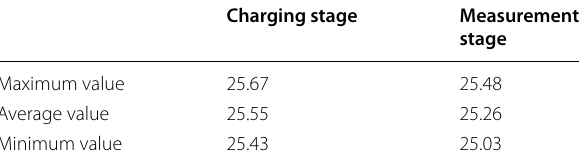
Table 3 Temperature characteristic data of two stages ( ℃